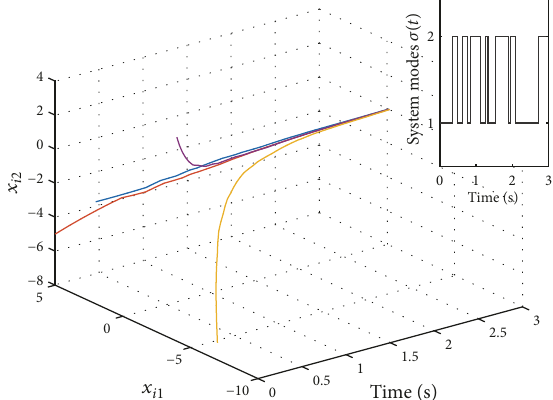
Figure 3: The state responses of the semi-Markovian jumping